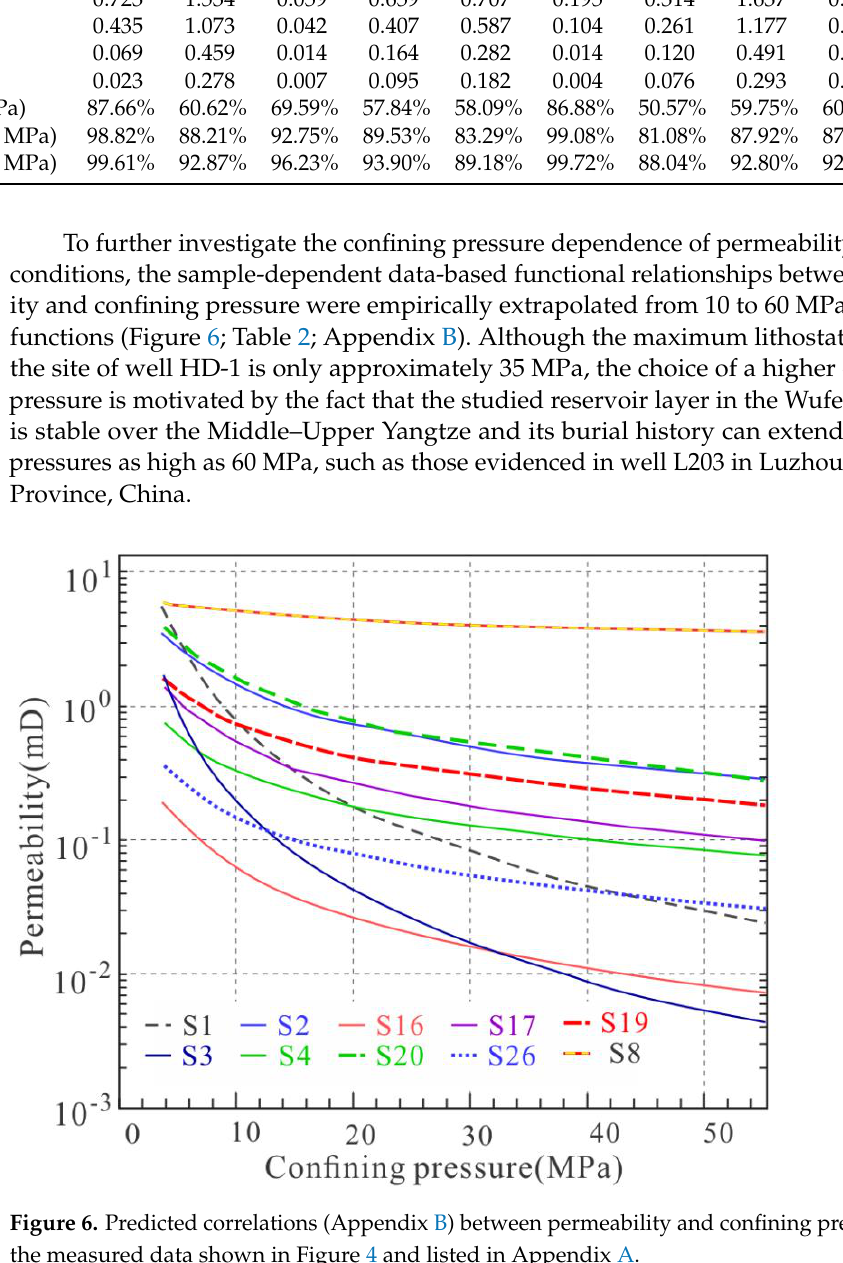
Figure 5. Klinkenberg permeability as a function of confining pressure for all tested samples, yield-